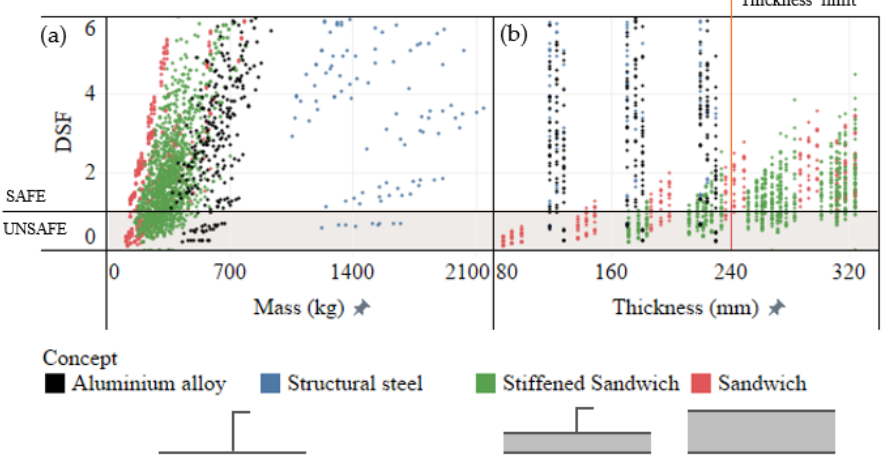
Figure 8. Comparison of deformation safety factors with respect to ( a ) mass and ( b ) panel thickness for all structural concepts.